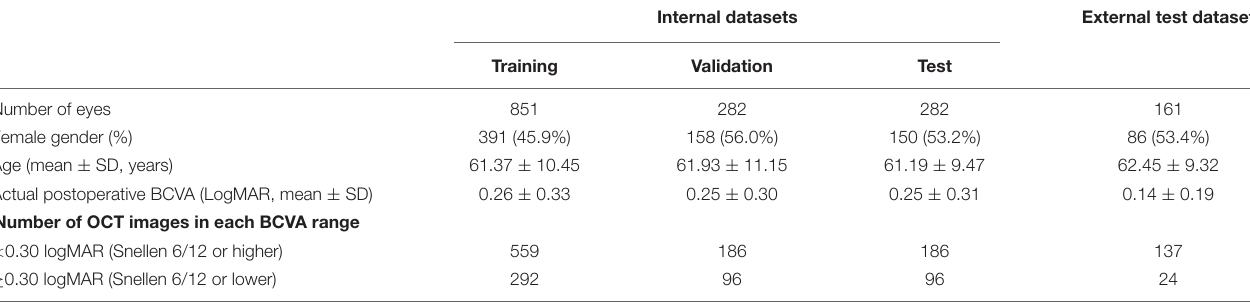
TABLE 1 | Demographic and clinical characteristics.